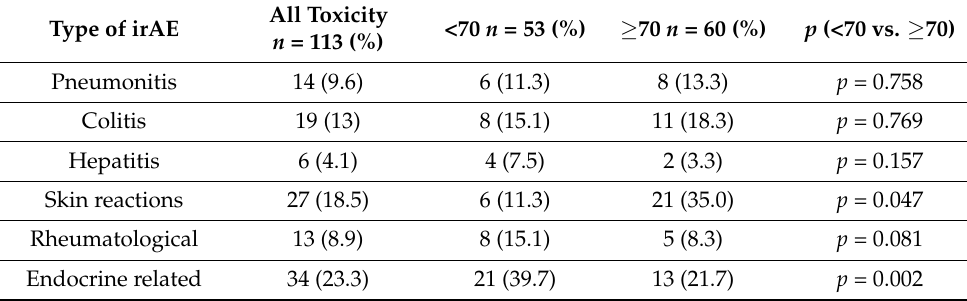
Table 3. irAE characteristics described by site/organ per each age